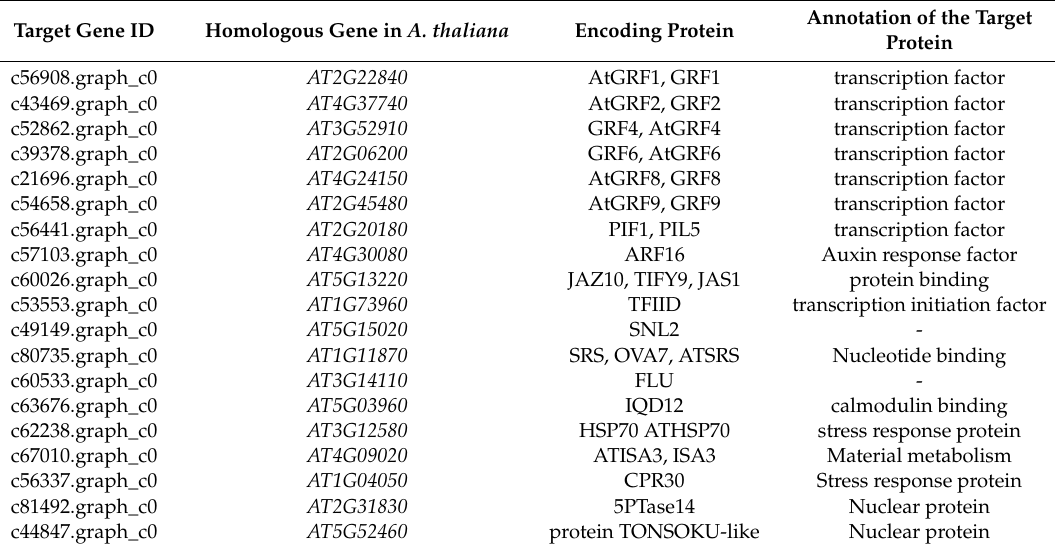
Table A1. Prediction results of hpo-miR396b target genes.